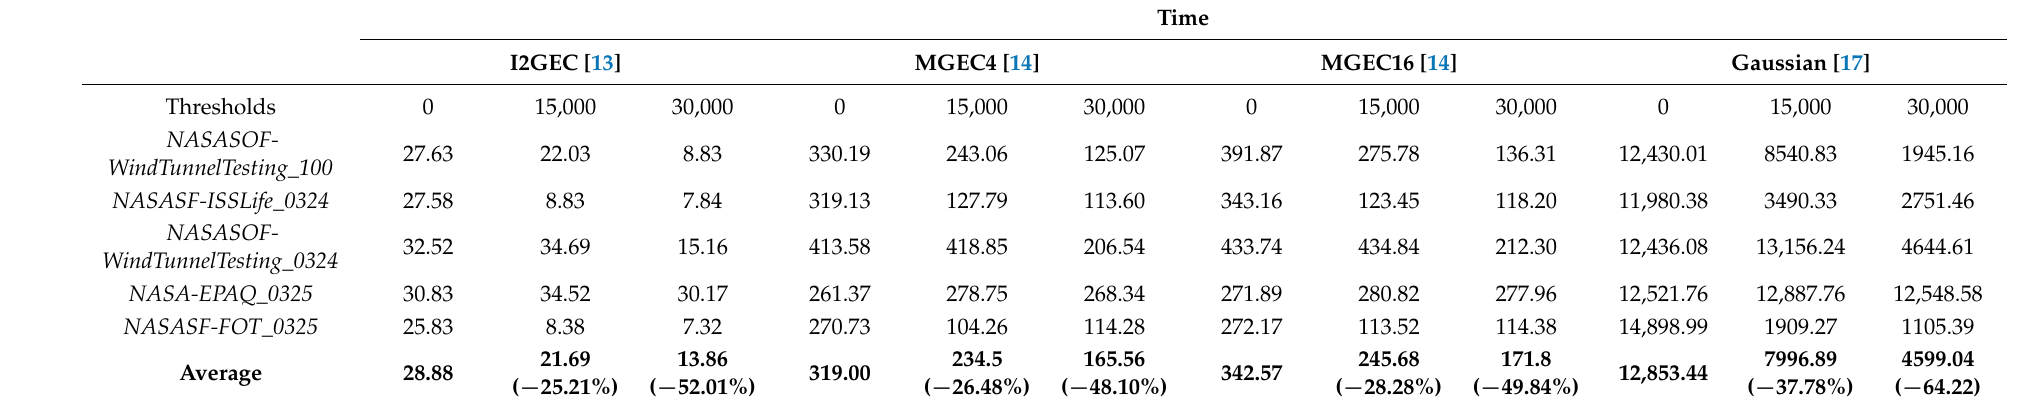
Table A1. Execution time (seconds; to the second decimal place) of different algorithms at different thresholds.